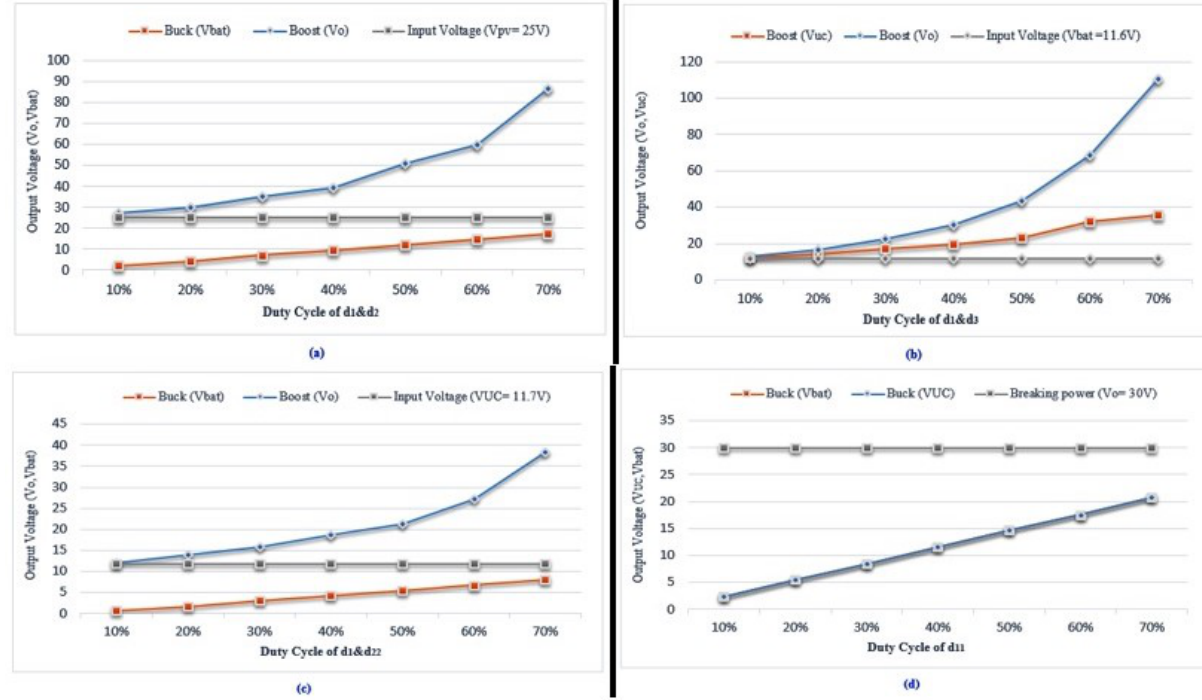
Fig. 7. Output voltages vs duty cycles (a) Case 1 (b) Case 2 (c) Case 3 (d) Case